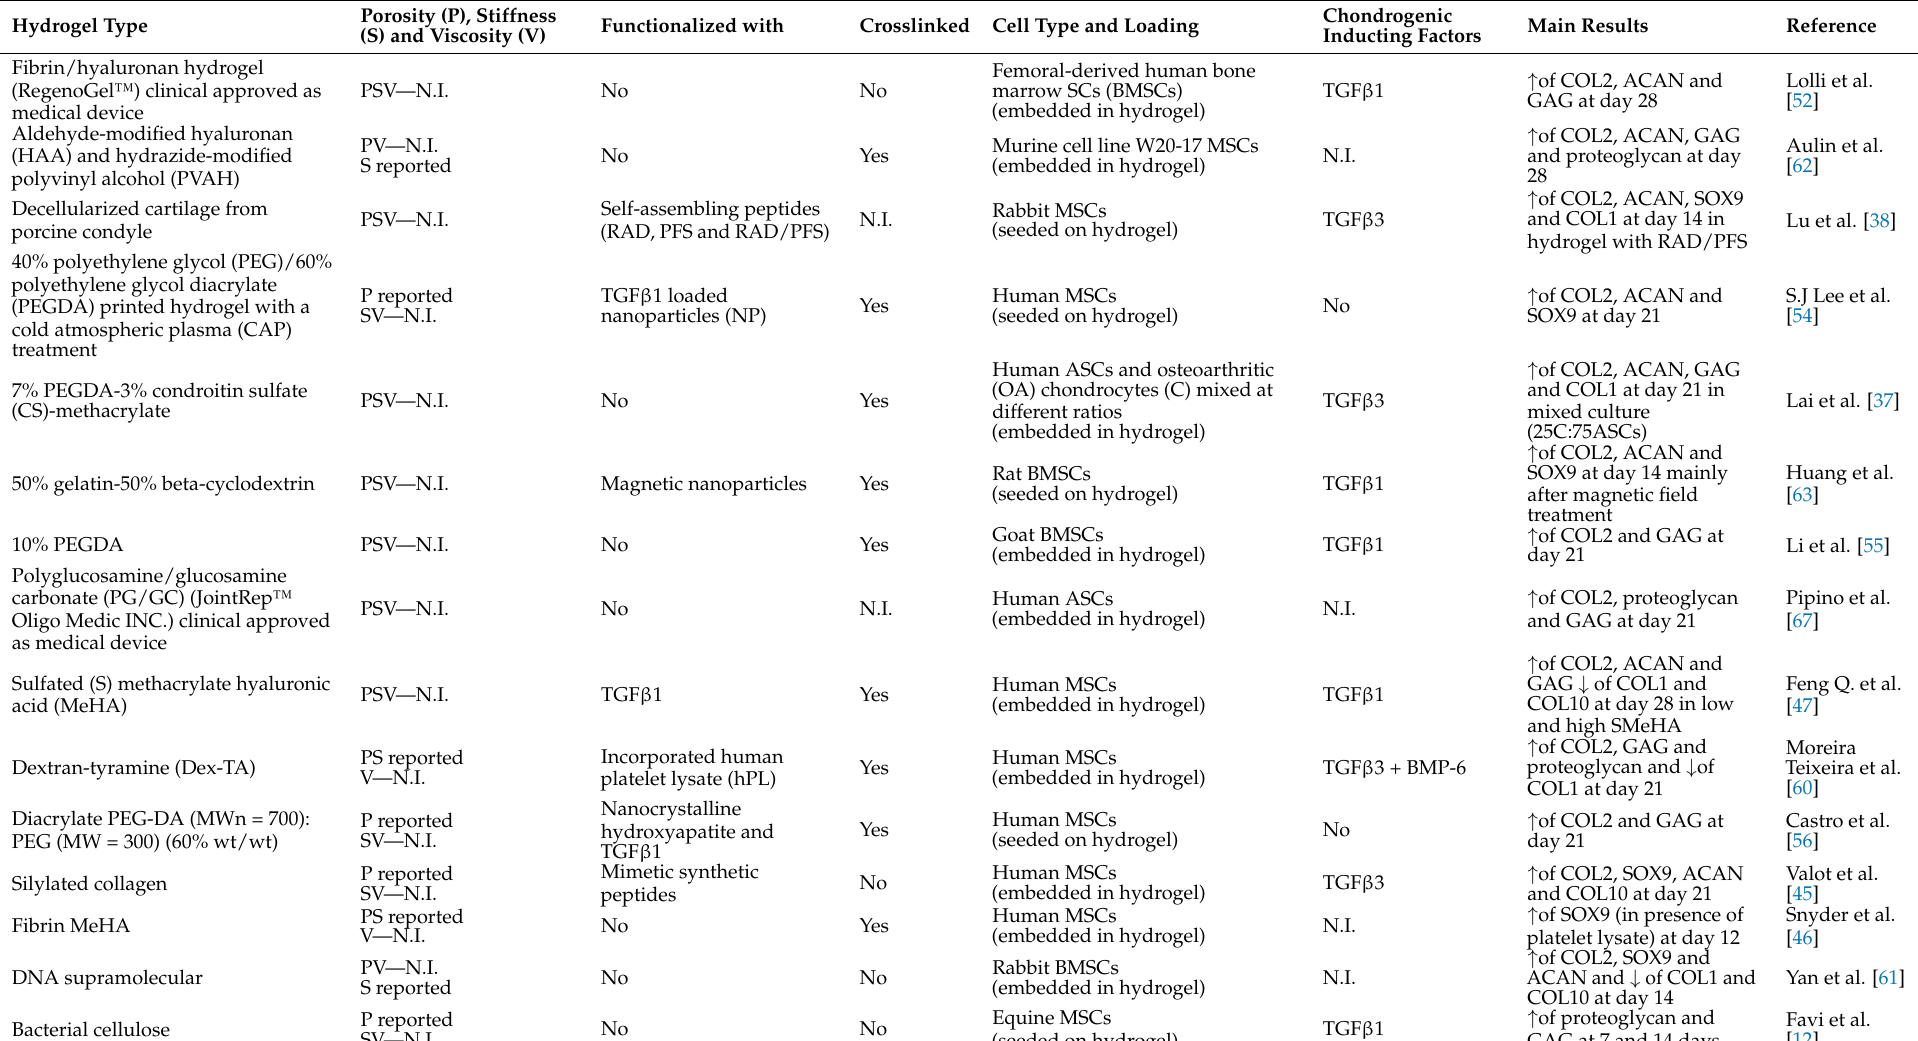
Table 1. Summary of the main results of selected in vitro